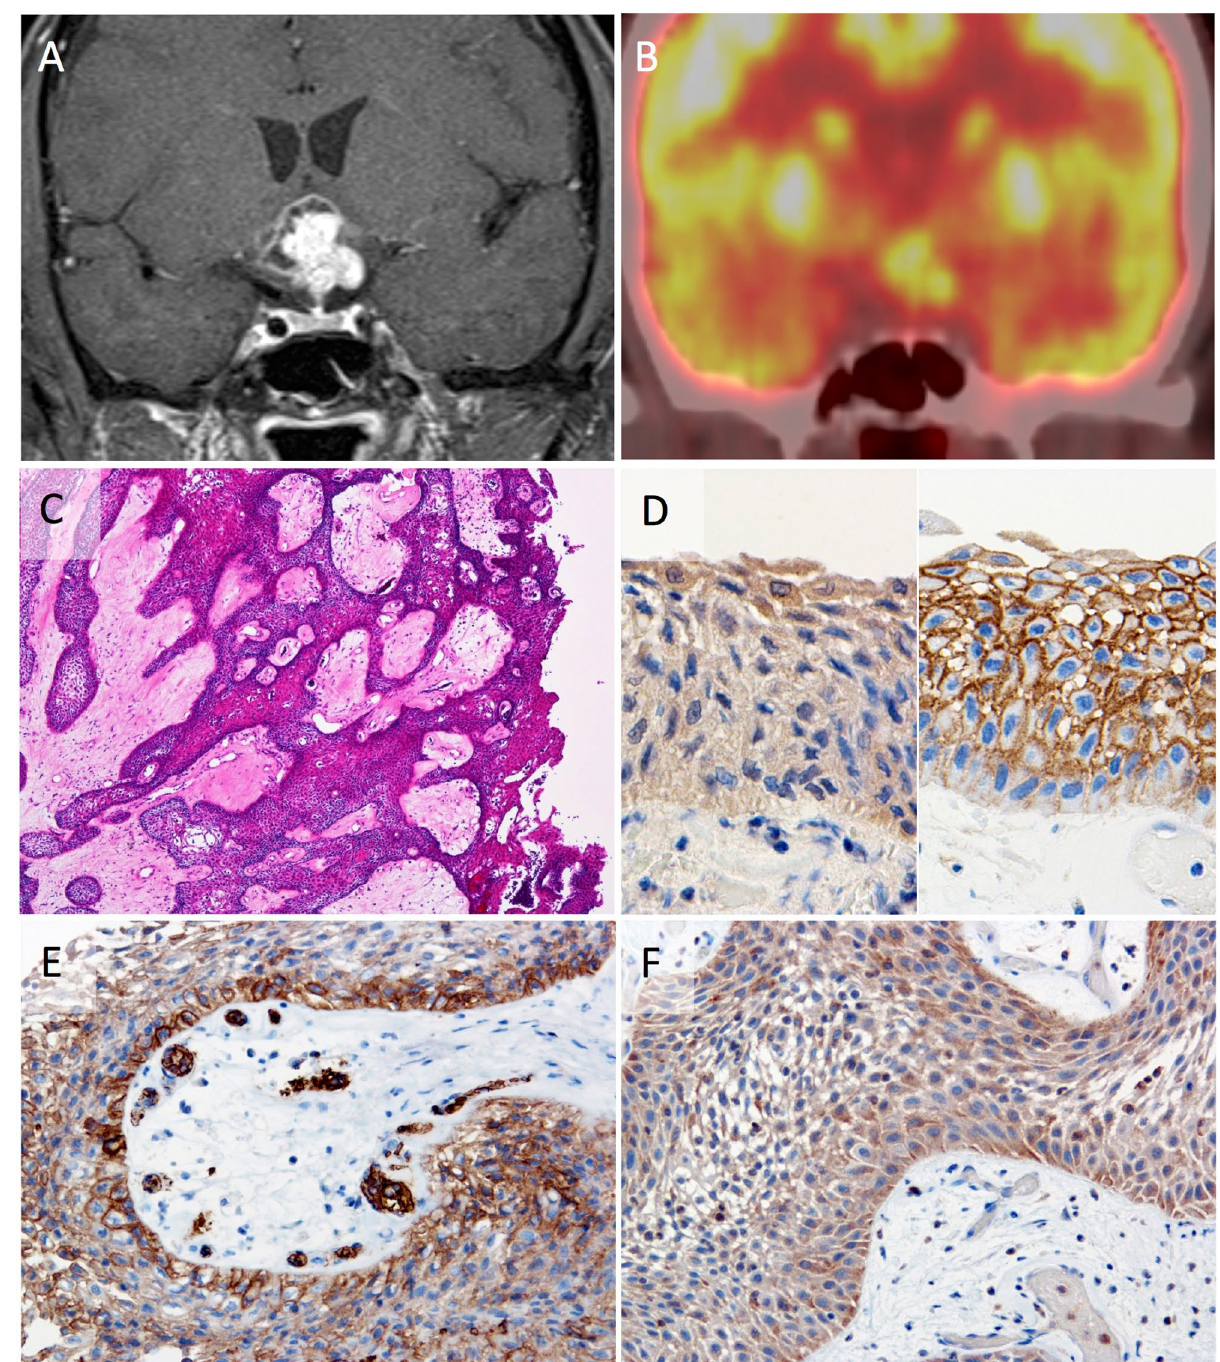
Figure 2. Case 1, a 57-year-old male patient with papillary craniopharyngioma. Preoperative coronal T1-weighted MR image after injection of gadolinium indicating an enhanced lesion with cysts in the suprasellar region ( A ). Preoperative [ 18 F]fluorodeoxyglucose positron emission tomography (FDG-PET) coronal image demonstrating enhanced glucose uptake in the suprasellar tumor ( B ). Histologically, tumor shows papillary structures composed of non-keratinizing squamous epithelium with fibrovascular cores ( C ) (hematoxylin and eosin, original magnification ×40). The tumor cells are positive for BRAF V600E ( D ; left, ×400) and no expression of beta-catenin in their nuclei are observed ( D ; right, ×400). The tumor is markedly positive for GLUT-1 ( E , ×200) and HK-II ( F ,